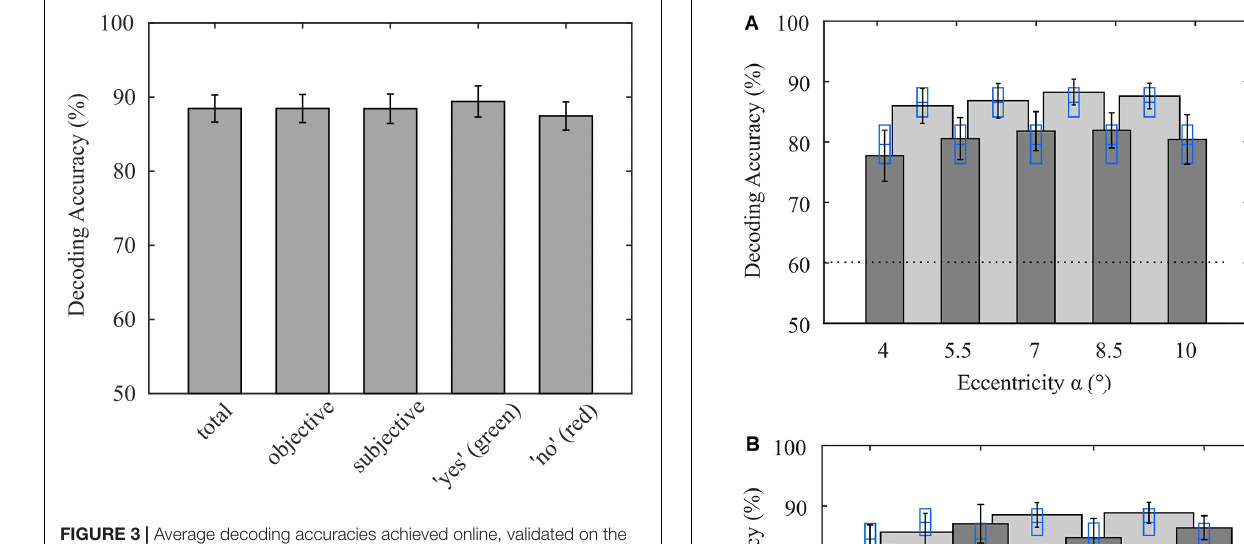
FIGURE 3 | Average decoding accuracies achieved online, validated on the entire data set, separated for objective and subjective questions, and separated for green and red targets. No significant differences were found for any sub group.